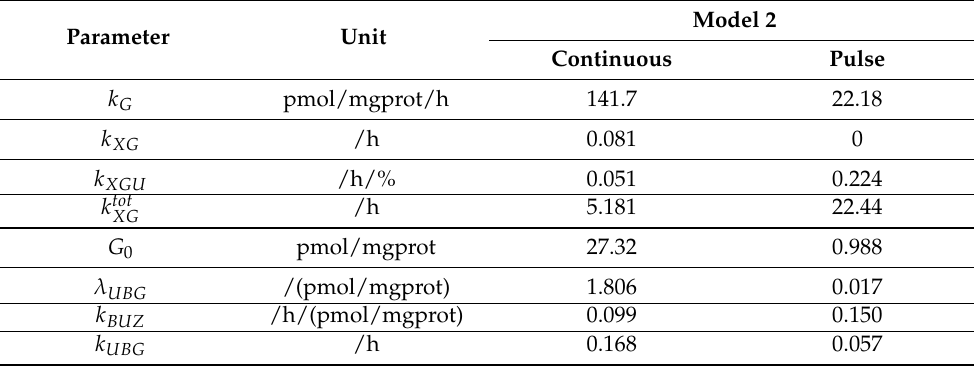
Table 3. Model 2: IPP antigen dynamics sub-model